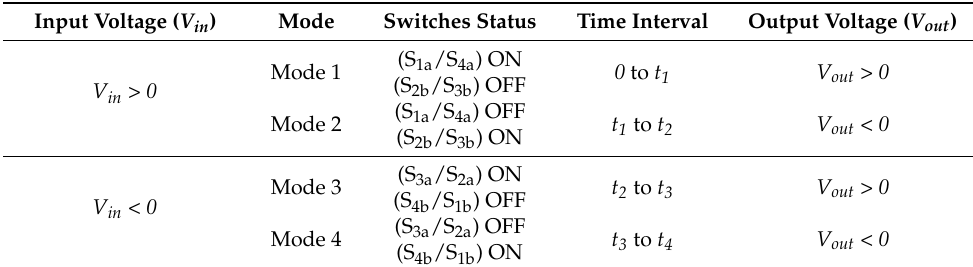
Table 1. Switches operation status of